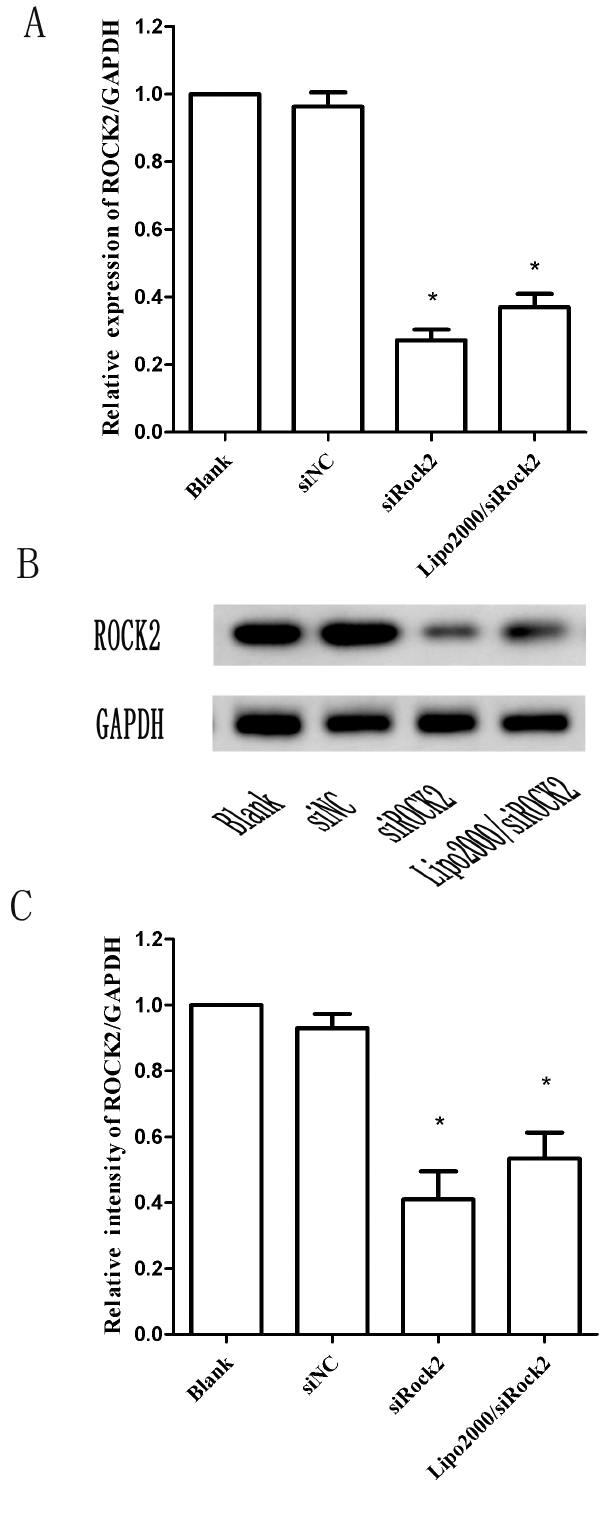
Figure 4. Gene silencing effects of siROCK2 complexes in U251 cells. A Relative mRNA expression of ROCK2 (N/P=50) in U251 cells 24 h after transfection. B Suppression of ROCK2 protein expression by the siROCK2 complex (N/P =50) in U251 cells 48 h after transfection. C The relative intensity of the corresponding Western blotting bands was determined using the Image-J software. The blank control was not treated, and siNC was a negative nonsense sequence of